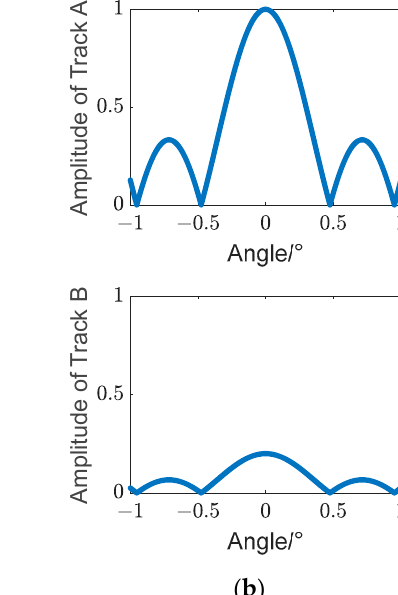
Figure 3. Schematic diagram of the amplitudes of the echo signal of insects crossing the beam at different positions. ( a ) Schematic diagram of the different positions of insects crossing the radar beam. ( b ) Amplitude of the trajectories produced by different insects.